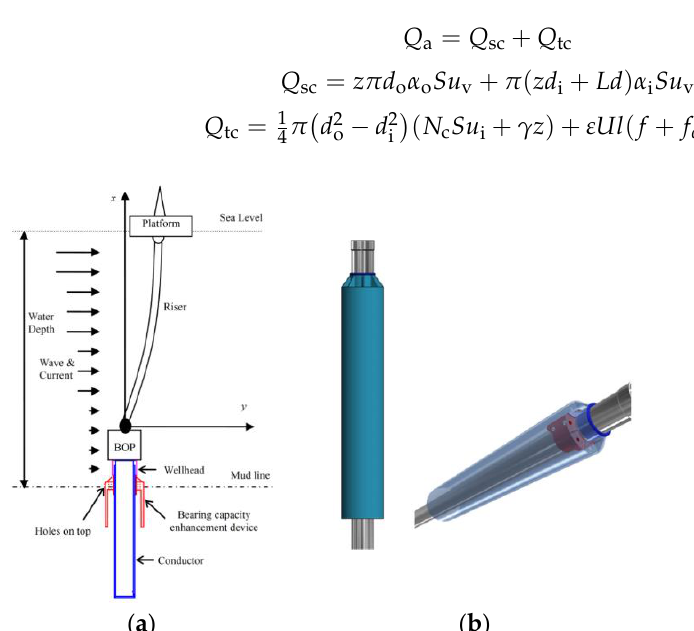
Figure 12. Conduit-bearing capacity strengthening device [This figure was modified with permission from ref. [164]. Copyright 2018, ASME].